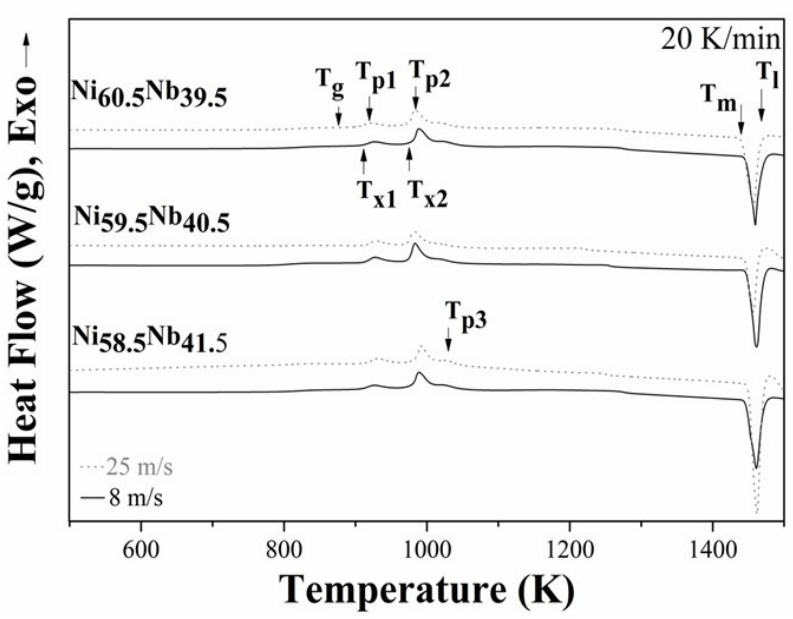
Figure 3. DSC curves of Ni 58.5 Nb 41.5 , Ni 59.5 Nb 40.5, and Ni 60.5 Nb 39.5 ribbons at a heating rate of 20 K/min.